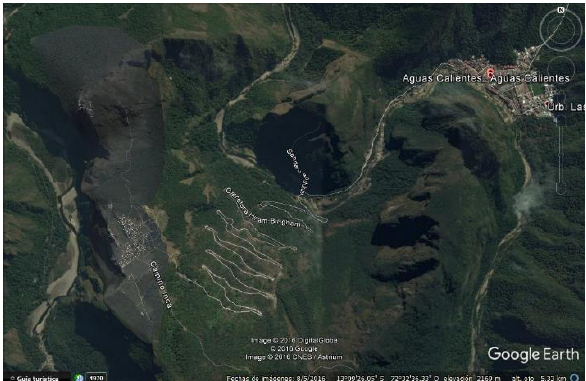
Figure 14. Geographical situation of Machu Picchu and its connection with the City of Aguas Calientes and the Inca Trail. © US Dept. of State Geographer. Google. Image: Screen capture, 2017. Google Earth.